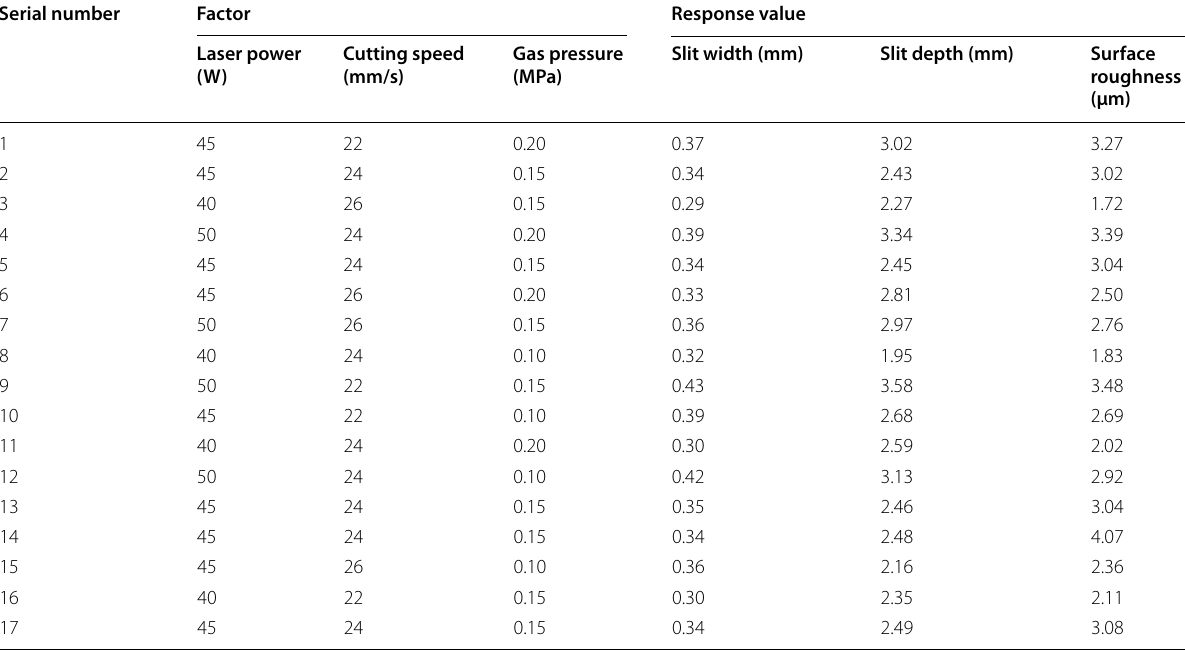
Table 3 Box–Behnken matrix and response values